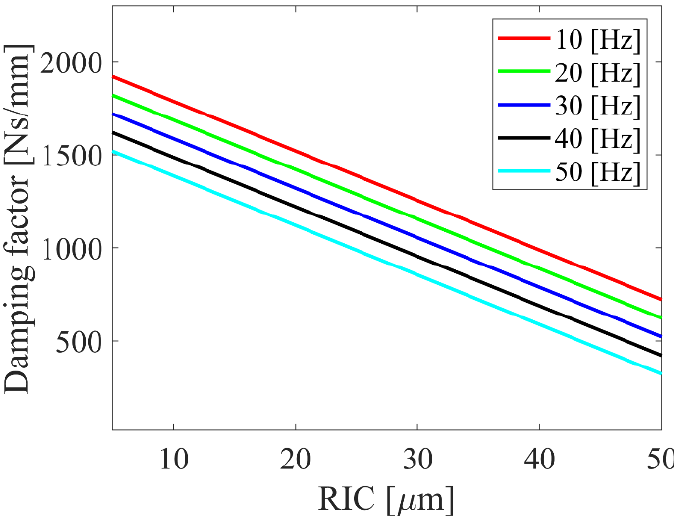
Figure 3. Damping factor functions in the radial internal clearance and rotational velocity domain. Table 1. Terms applied for the mathematical model of the ball